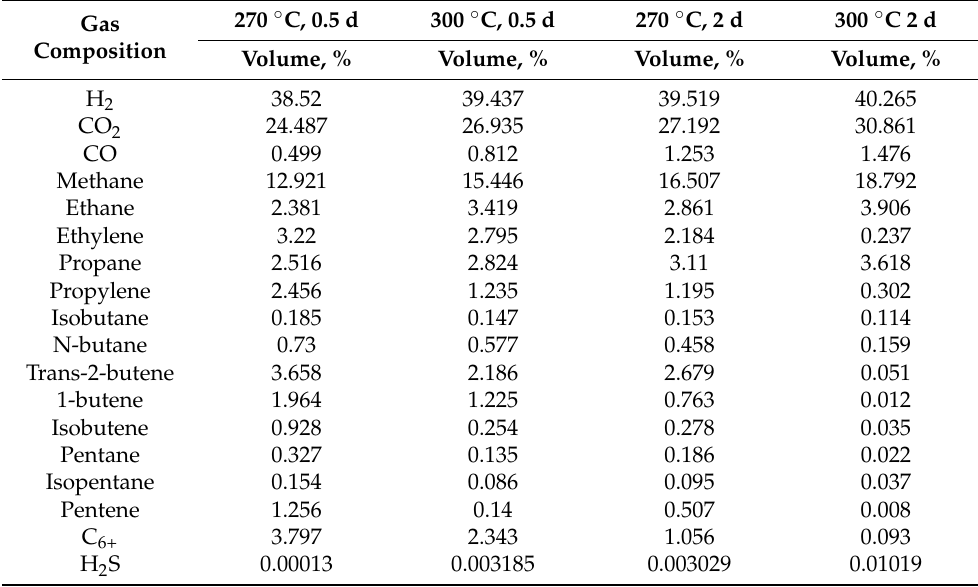
Table 2. Results of gas chromatography for gas products at different reaction temperatures and